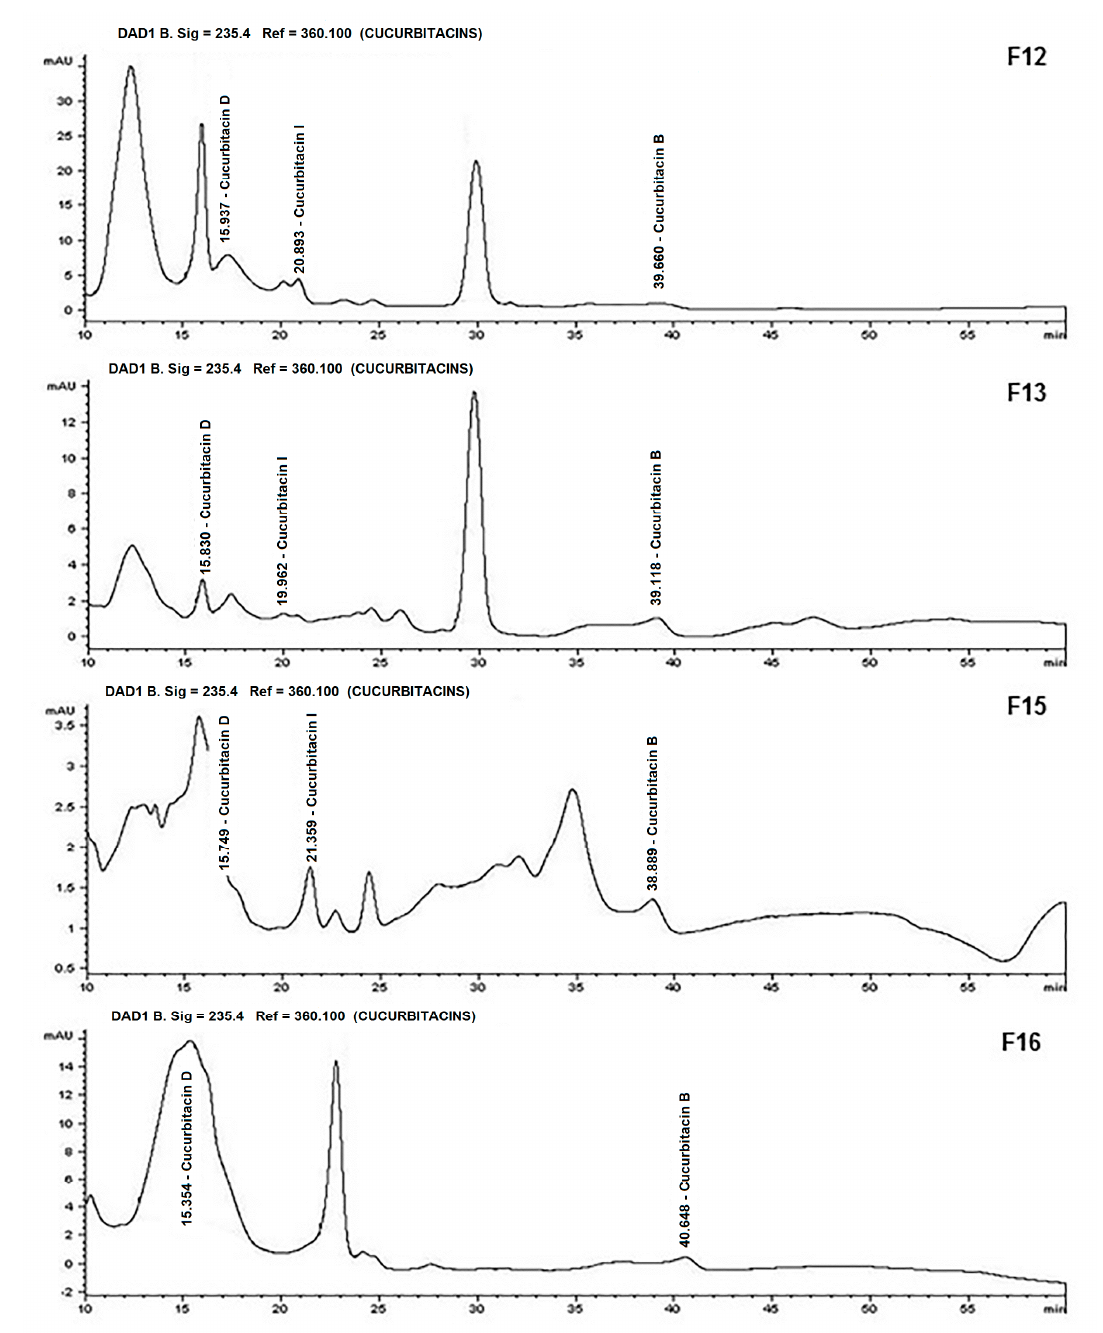
Figure 3. Identifying compounds by HPLC. Chromatograms of the terpenes (cucurbitacins) that showed biological activity, which were obtained from the methanol extract of Perla Negra through column chromatography, where the presence of cucurbitacins and other non-identified compounds is confirmed at 235 nm.